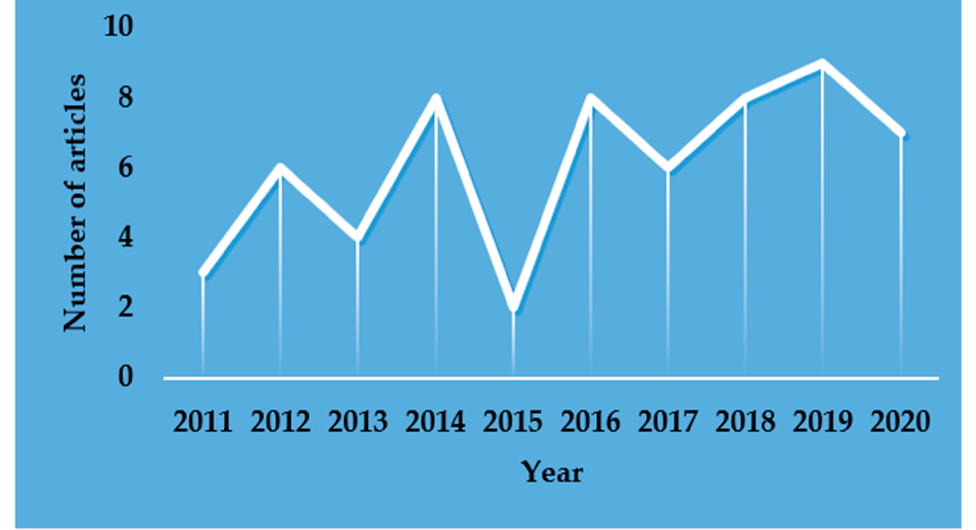
Figure 3. Annual distribution of reviewed articles.